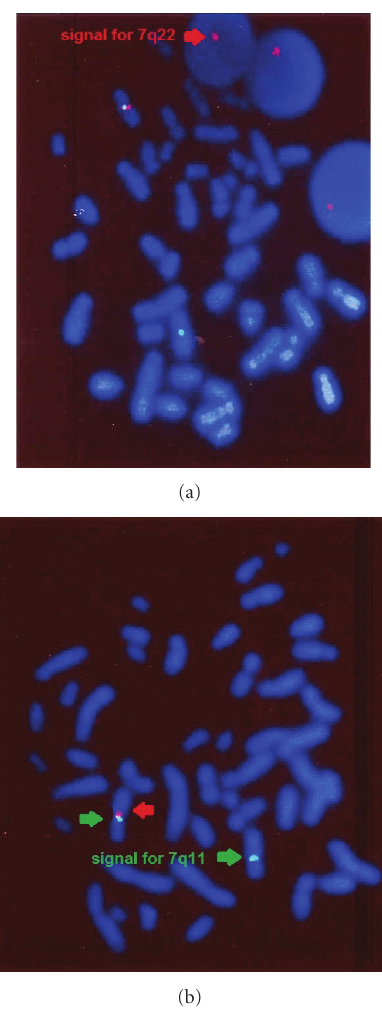
Figure 5: FISH report: signal for 7q11 is labeled in green and 7q22 region is labeled in red. Fluorescent in situ hybridization was performed using cytocell Williams-Beuren region probe. The Williams-Beuren region probe is optimized to detect copy numbers of the ELN gene region at 7q11.2. The 7q22 region-specific DNA probe at 7q22 is included as control probe, where the signal for 7q11 is labeled in green and 7q22 region is labeled in red. The patient was found to have two chromosomes 7, one of which showed no signals corresponding to the test probes diagnostic Williams